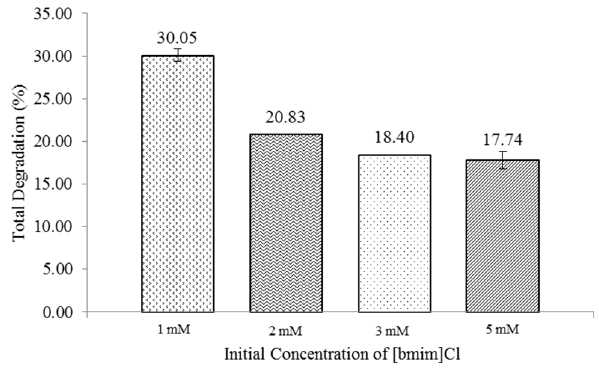
Figure 5. Efficiency of [bmim]Cl photodegradation system at different [IL o ].